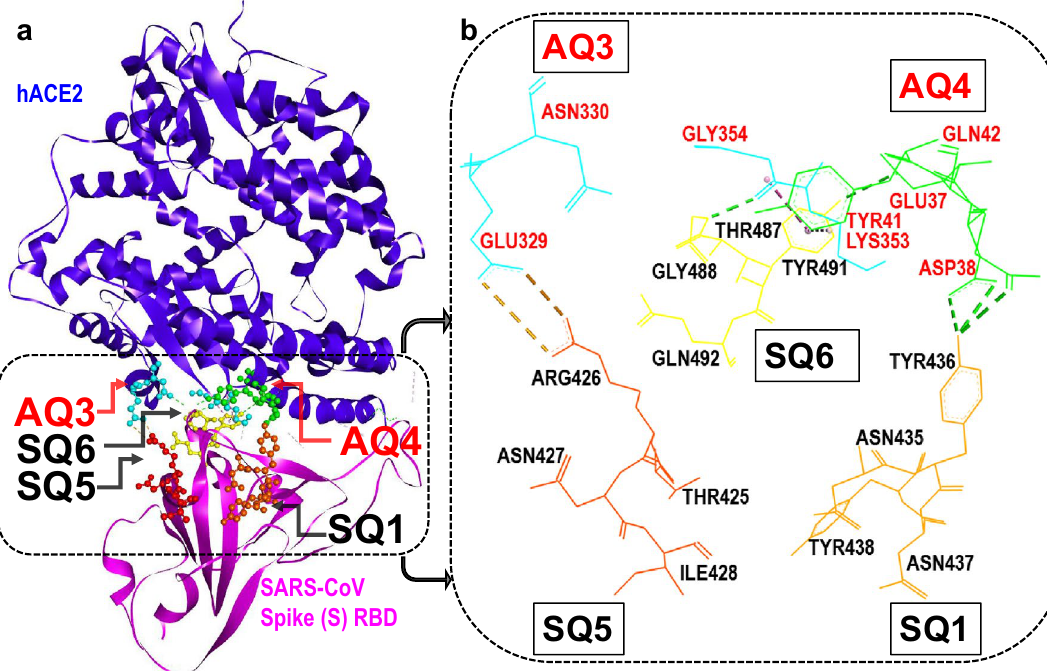
Figure 1. Identification of four-residue fragments (i.e. quartets ) which produce attractive interaction energies between hACE2 and the SARS-CoV-1 S-RBD. ( a ) Structure of hACE2 receptor (Chain A) in complex with SARS-CoV-1 spike protein (Chain E) 3 . The key quartets , at the hACE2...S-RBD interface, promoting host-virus binding are shown in the dashed box. ( b ) Magnified view of the hACE2 ( AQ3 , AQ4 ) and S-RBD ( SQ1 , SQ5 , SQ6 ) residue quartets which mostly contribute to the attractive hACE2...S-RBD interaction energy. Residues for each quartet are